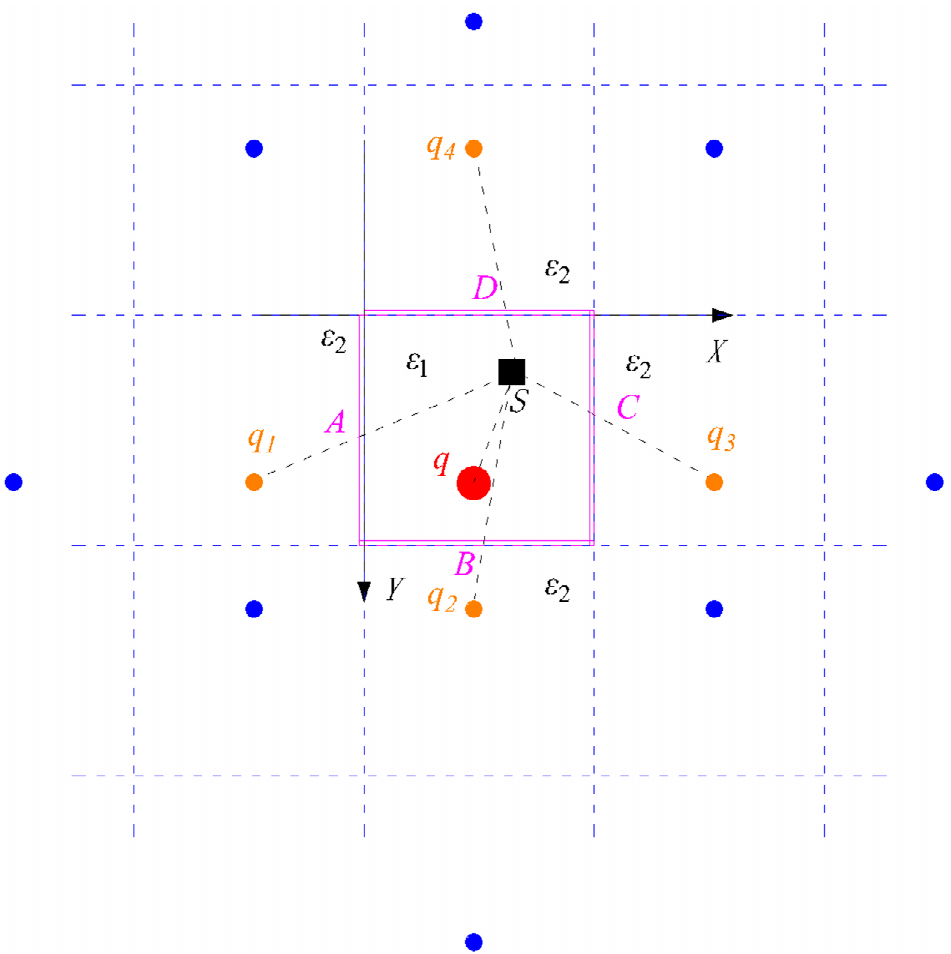
Figure 15. Schematic map of imaging method for solving EPs under finite boundaries. The red solid circle and the pink box refer to actual point charge and four boundaries, respectively. Brown solid circles denote the initial imaging charge of actual point charge at the aforementioned boundaries while blue solid circles represent new imaging charges generated based on the initial imaging charges at the corresponding boundaries. The solid box refers to the location of the point 𝑆 .